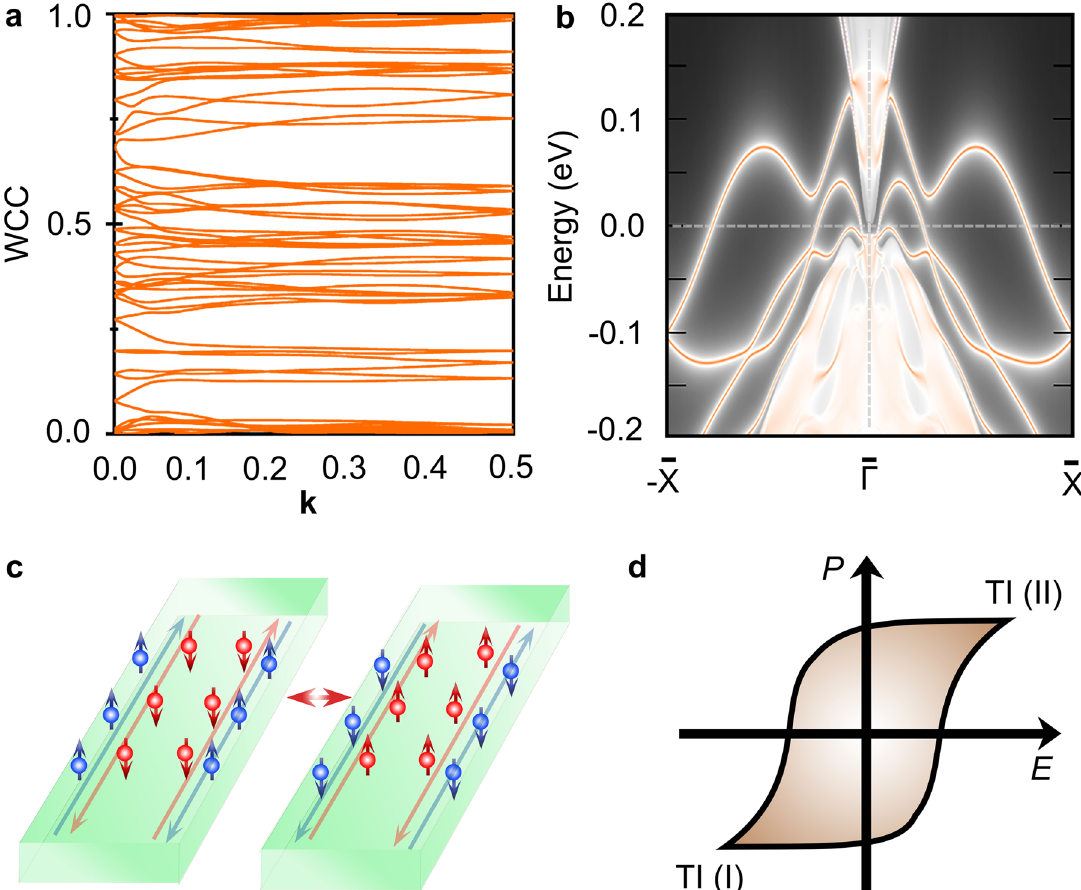
Fig. 3 Topological properties and coupled ferroelectricity and band topology. a Evolution of the WCC along k y for β 1 -Bi 2 Te 3 . b TB band structure of armchair-edged nanoribbon of β 1 -Bi 2 Te 3 obtained by MLWFs, showing edge states inside the gap of bulk bands. c Proposed electrical switch of the chirality and direction of the spin-locked current at boundary. d Schematic representation of 2D FETI with two polar TI